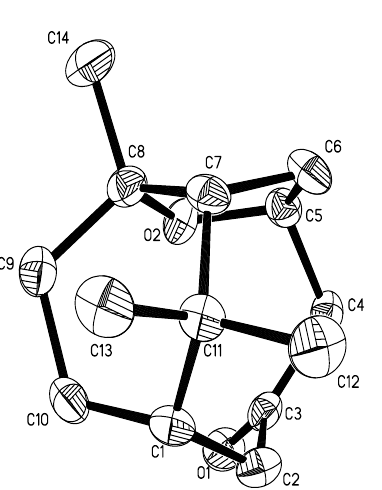
Figure 4. X-ray structure of compound 1.